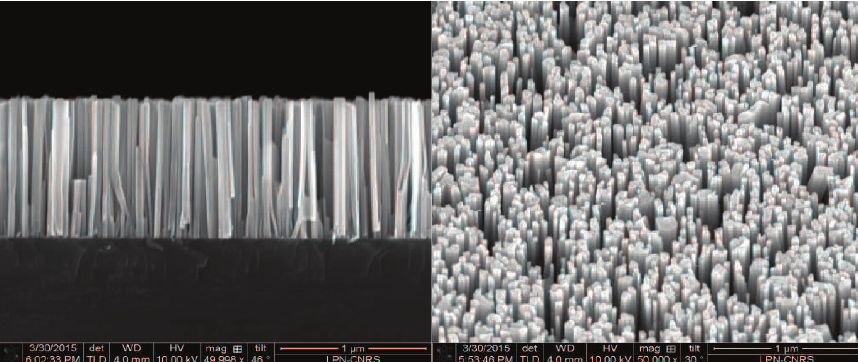
Figure 1. Scanning electronic microscope picture of GaN NWs (Gallium nitride nanowires) on n-doped Si (111) substrate before the encapsulation into a polymer matrix. All NWs are vertical.The density is of the order of 10 10 NWs/cm 2 . The filling factor is